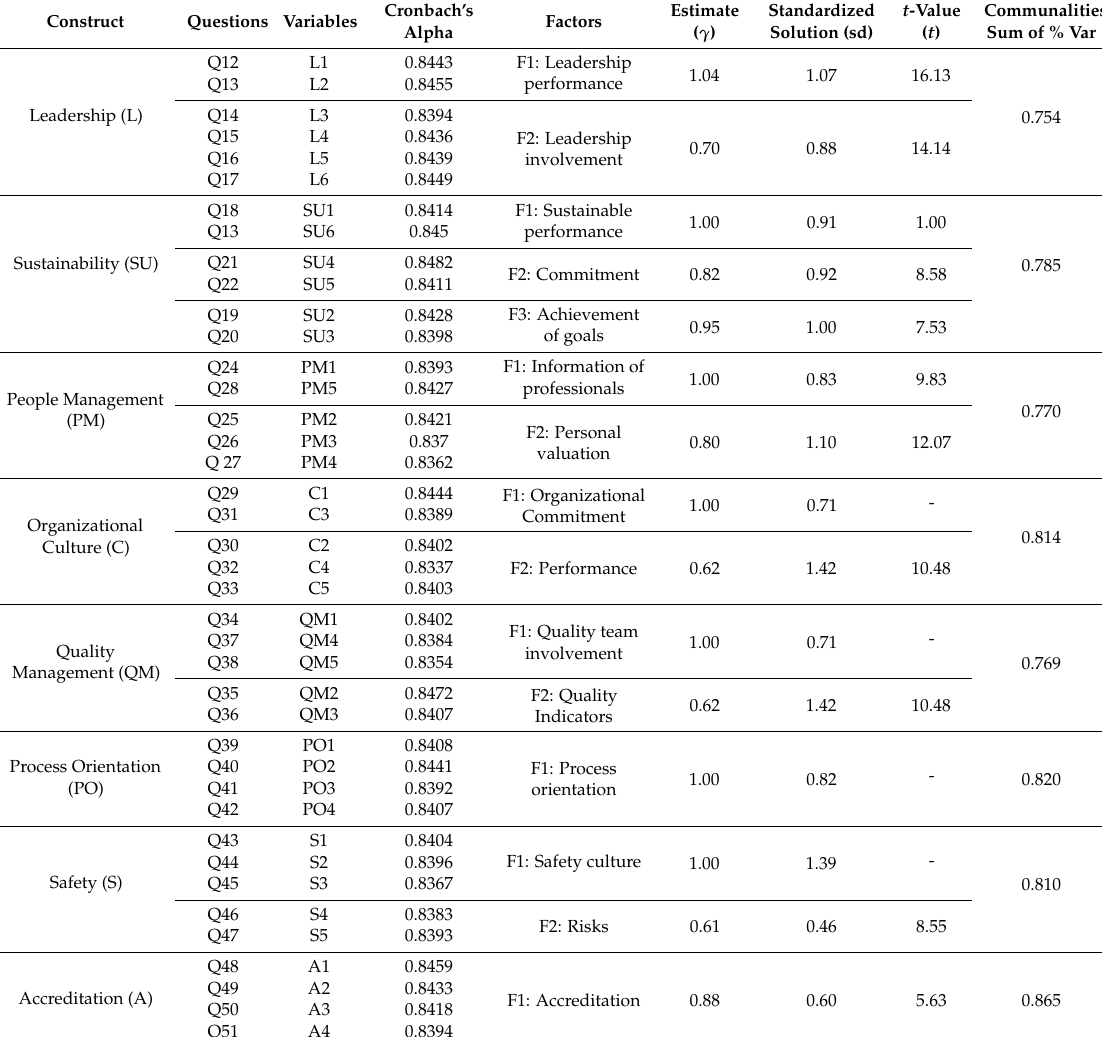
Table 1. Confirmatory factor analysis (CFA)